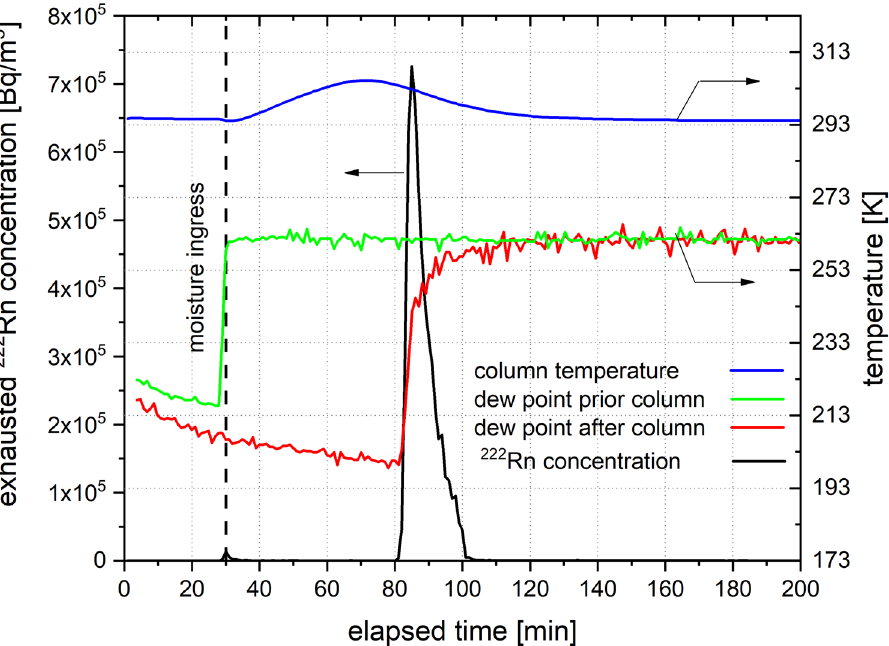
Figure 3. Measured release of 222 Rn from Ag-ETS-10 upon contact with laboratory air of 55% rel. humidity at 294 K; flow rate 2 NL/min; mass of adsorbent—16.3 g; injected 222 Rn activity—11.7 kBq; 30 min post